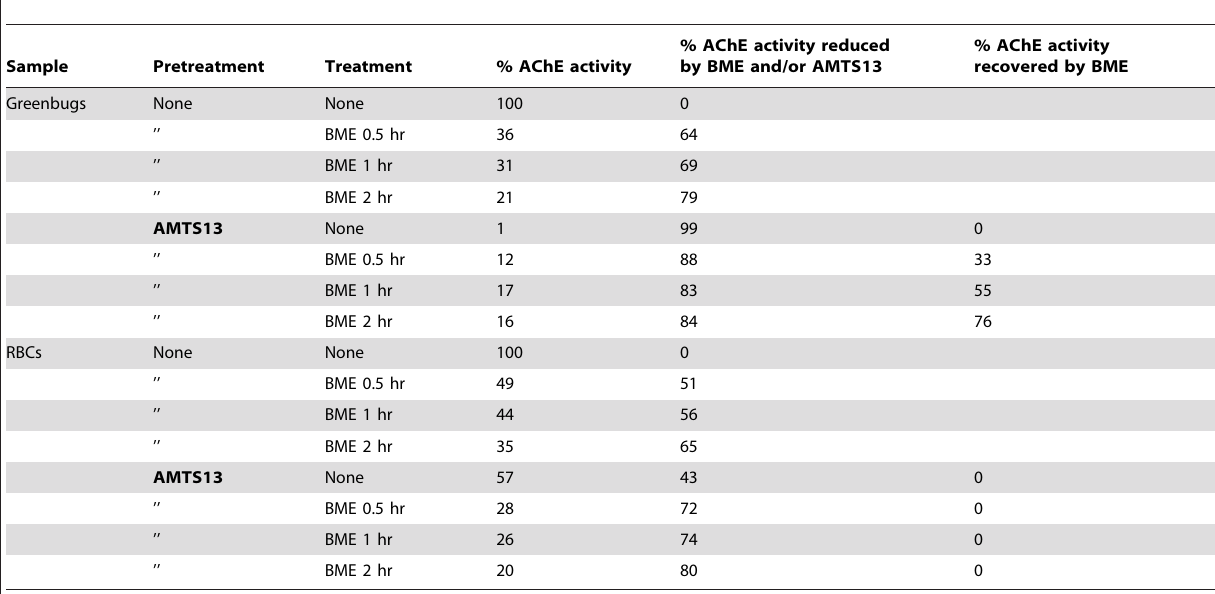
Table 1. Reactivation Studies of the Greenbug and Human Acetylcholinesterases (AChEs) Inhibited by AMTS13 Using b - Mercaptoethanol (BME) That Can Reverse the AMTS13 Inhibition and Concomitantly Denature the Disulfide-Containing AChEs.